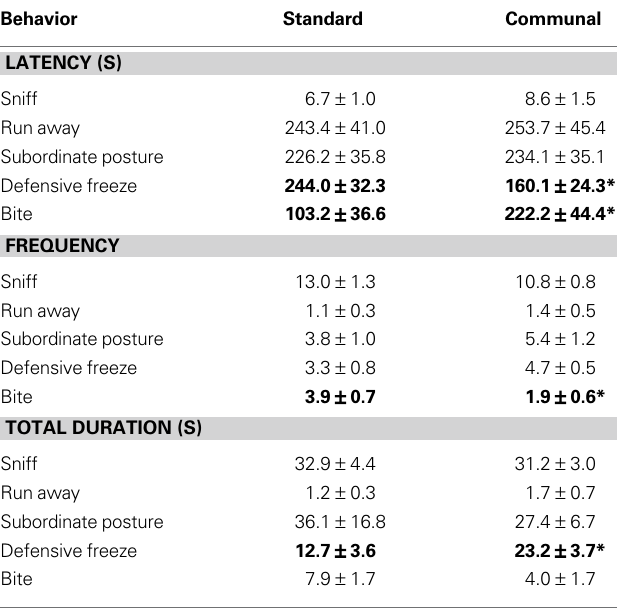
Table 3 | Lactational aggression of F1 standard vs. communally reared